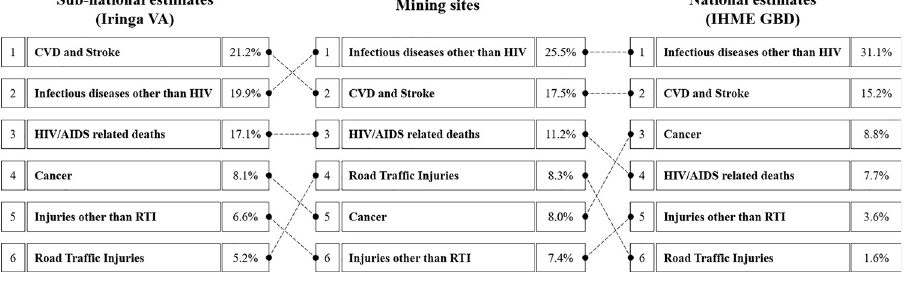
Fig 2. Causes of death